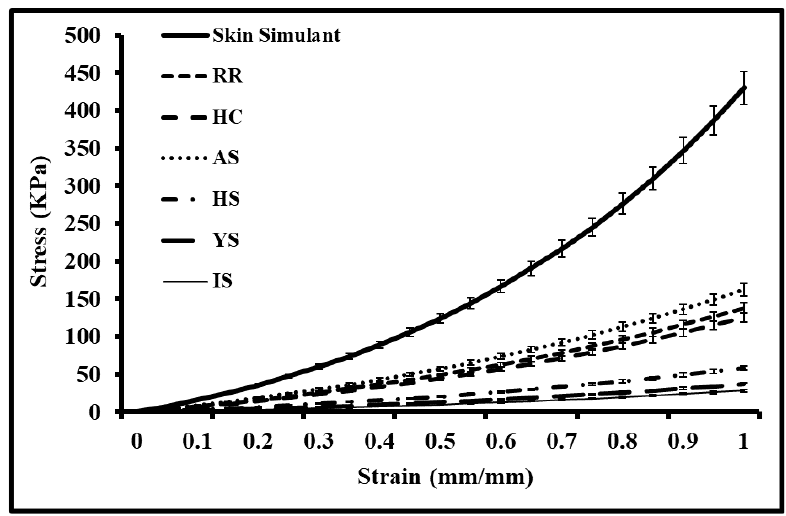
Figure 6. Stress – strain analysis of different auxetic skin graft simulants up to 100% stretch.